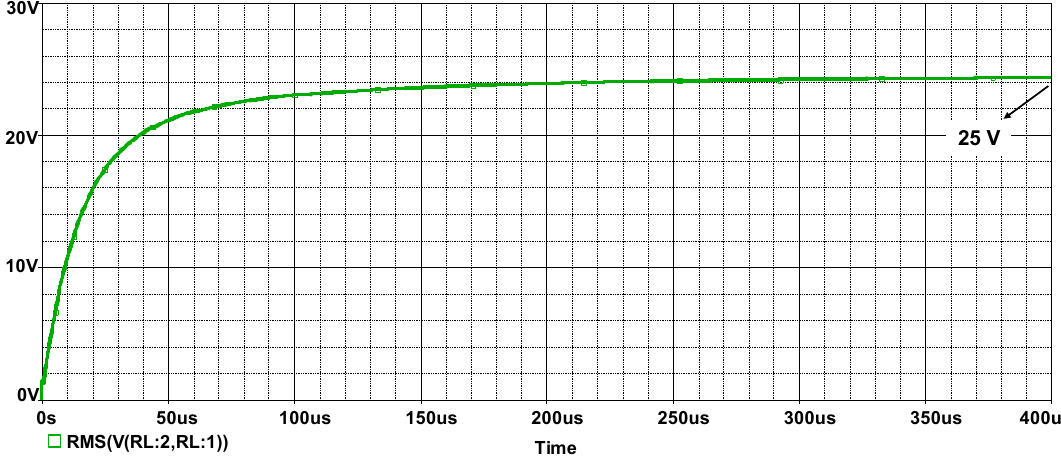
Figure 8. Series RLC circuit designed in the transient state simulated in OrCAD PSpice.